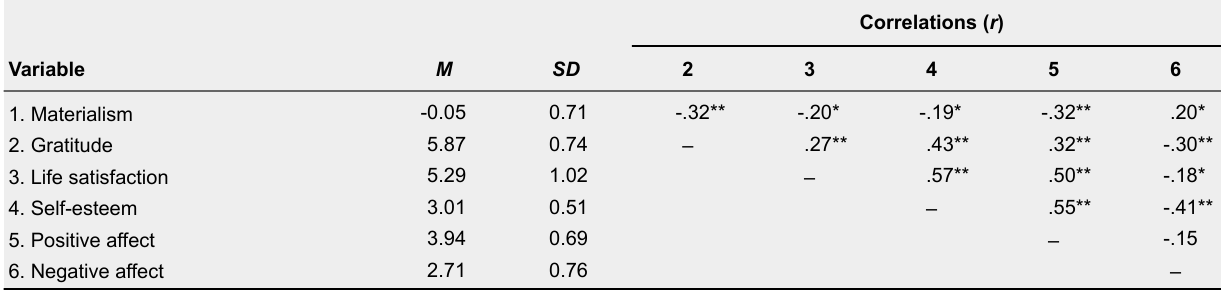
Descriptive Statistics for All Main